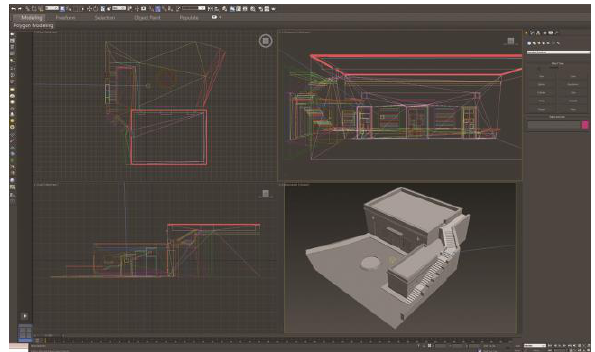
Figure 2. The Royal Park of Tirana. 3D model of the Church created by the digital platform.